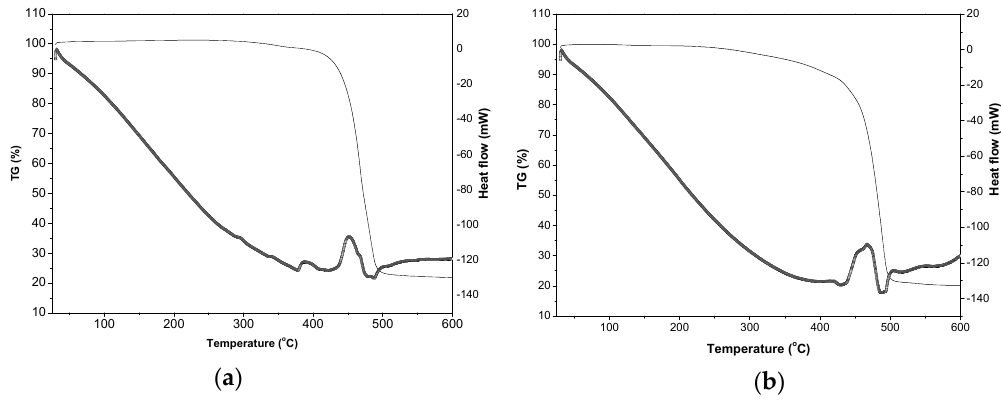
Figure 4. Typical TGA curves of ME-FILs. ( a ) ME-FIL 1 ; ( b ) ME-FIL 4 .